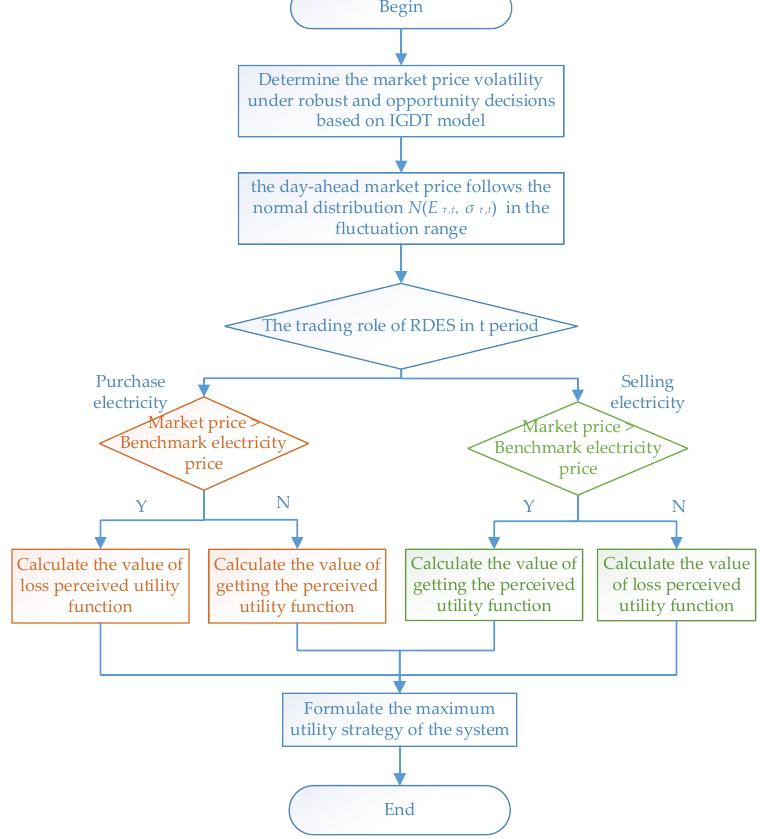
Figure 2. Optimal decision-making process with utility function for DERA.